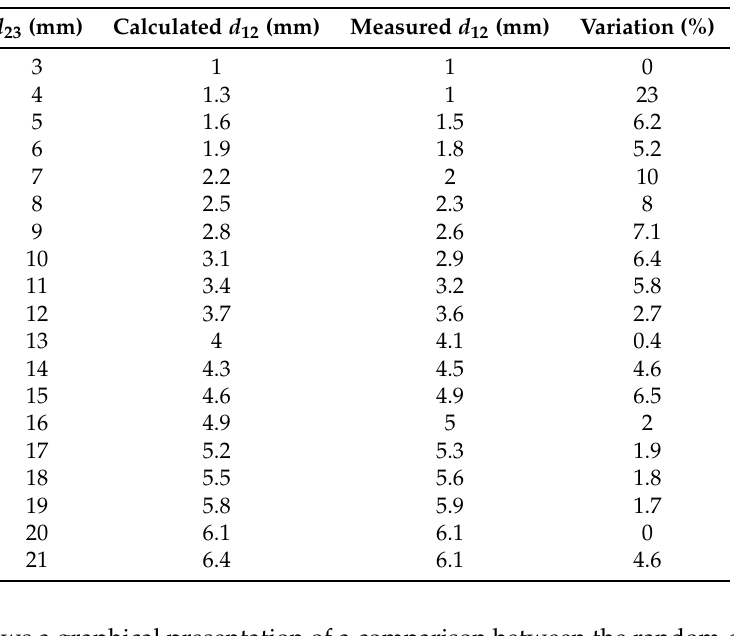
Table 2. Comparison between the measured and calculated distances ( d 12 ) and variation between the two in %.